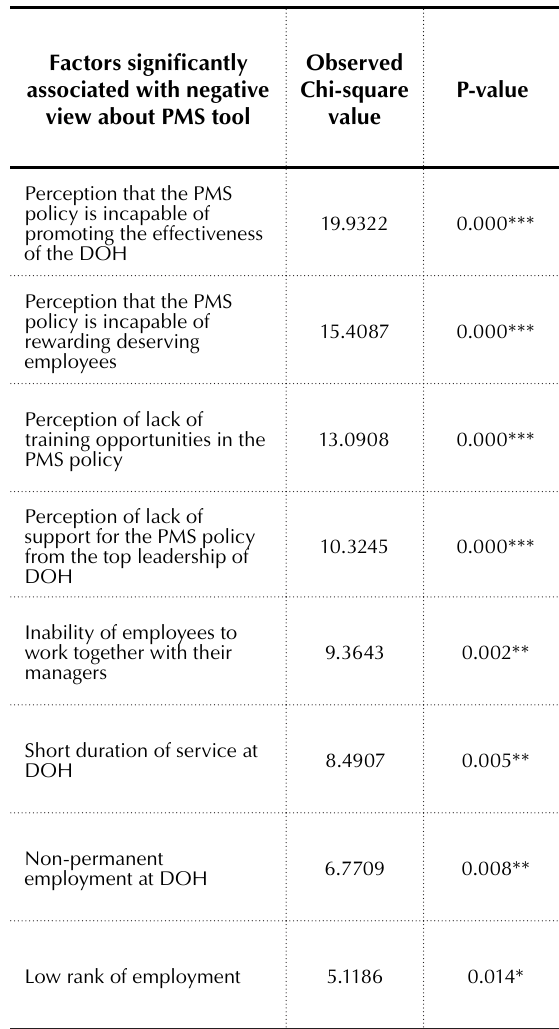
Table 2. Results obtained from cross-tab analyses